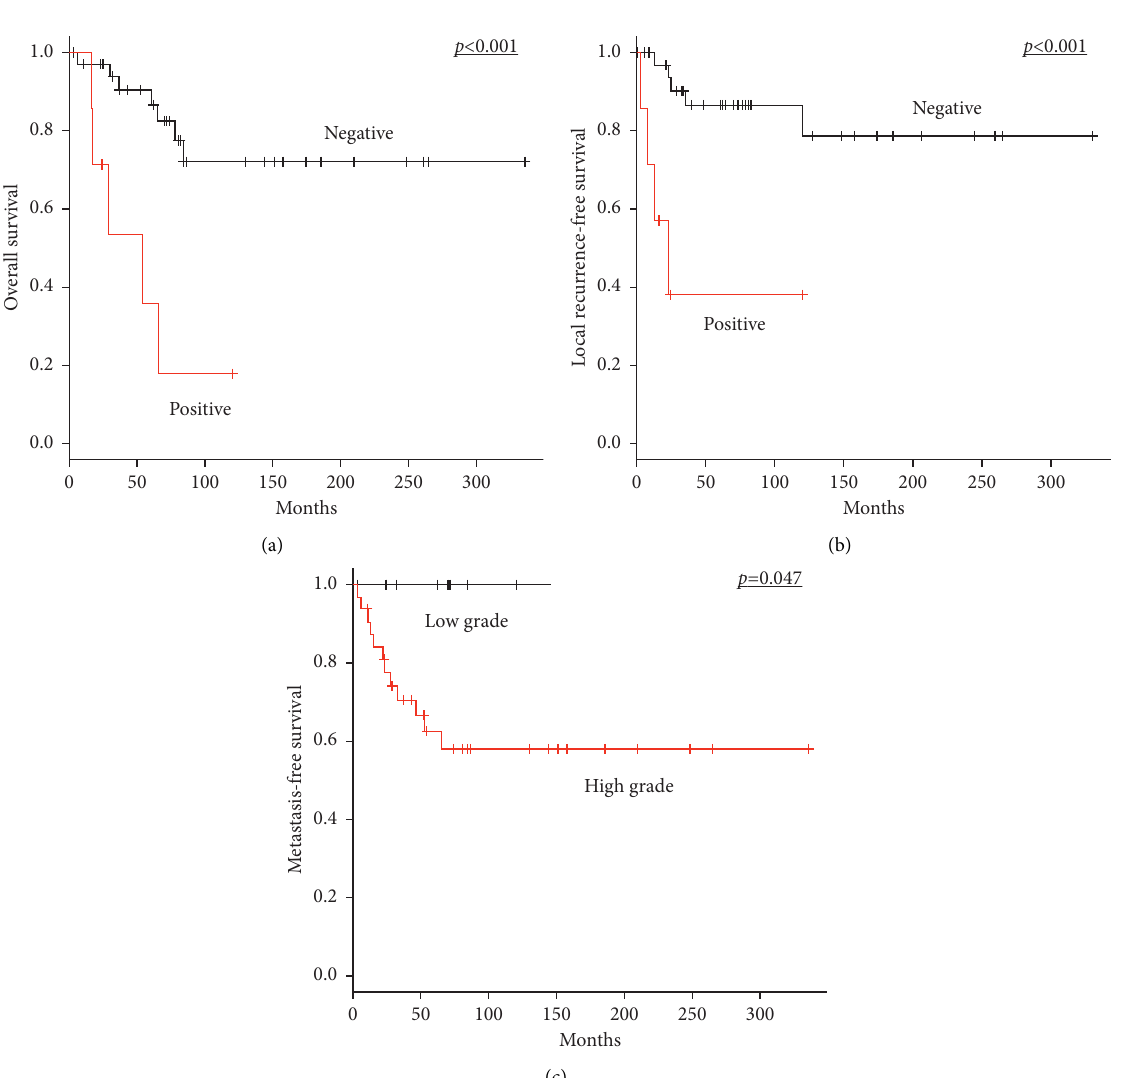
Figure 2: Kaplan–Meier survival curves in 42 patients with nonmetastatic MPNST who underwent surgery of the primary tumour at our institutions. (a) OS according to surgical margin status (negative margin versus positive margin). (b) LRFS according to surgical margin status (negative versus positive margin). (c) MFS according to histological grade (low grade versus high grade). MPNST, malignant peripheral nerve sheath tumour; OS, overall survival; LRFS, local recurrence-free survival; MFS, metastasis-free